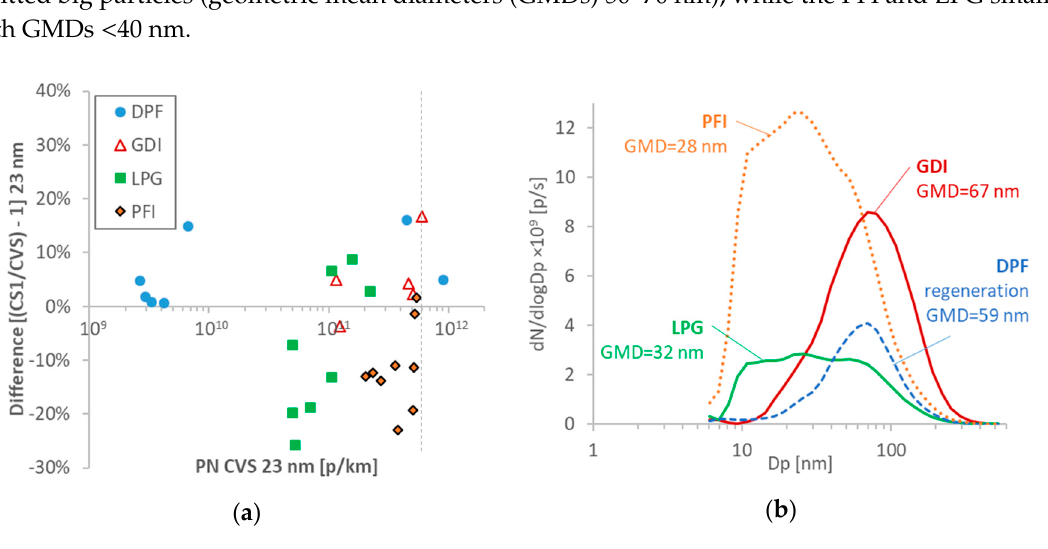
Figure 2. Basic results: ( a ) comparisons of 23-nm particle number (PN) reference systems at the tailpipe and the dilution tunnel (CVS). Each point is a test cycle. The dotted vertical line gives the laboratory PN emissions limit; ( b ) examples of size distributions for the various vehicles, measured with the engine exhaust particle sizer (EEPS) downstream of a catalytic stripper (CS) at 300 °C and multiplied with the CVS flow rate to make the concentrations comparable. DPF = diesel particulate filter; GDI = gasoline direct injection; GMD = geometric mean diameter; LPG = liquefied petroleum gas; PFI = port fuel injection.